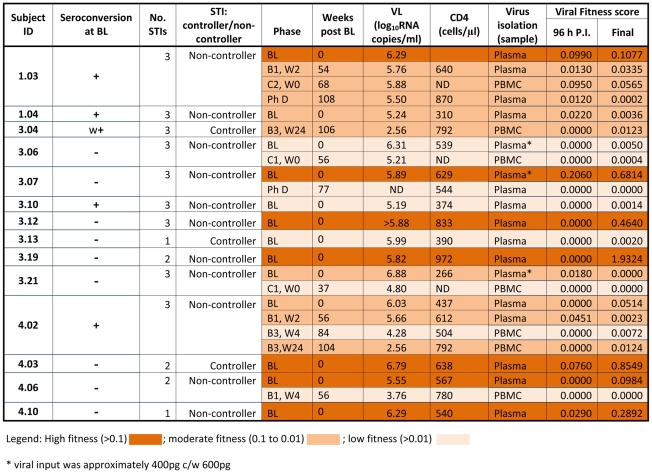
Viral fitness scores and clinical data for PULSE subjects.Shown are clinical and experimental data obtained for PULSE subjects from which virus was successfully isolated and subsequently tested using the real time PCR assay. Indicated by the column headings are the subject identification code and seroconversion status at Baseline (‘+’ indicates subject had seroconverted, ‘−’ indicates subject was seronegative, ‘w+’ indicates that a weak antibody response was detected). Also shown are the number of STIs experienced by the subject, whether VL was suppressed below 5 000 RNA copies/ml upon STI (indicated by ‘controller’ or ‘non-controller’), and the phase of the PULSE study during which the relevant sample was collected. The time (in weeks) post Baseline that the sample was collected, coincident VL and CD4+ T cell counts and the sample type from which virus was successfully isolated, are also shown. Finally, viral fitness scores calculated using DNA production measured at 96 h post-infection ex vivo, and at the final time-point analysed (158 h post-infection), are shown for each isolate. The fitness scores generated for the isolate obtained from subject 3.13 were calculated from total HIV-1 DNA produced at 60 and 72 h post-infection. ‘ND’ indicates that the specified measurement was not done.